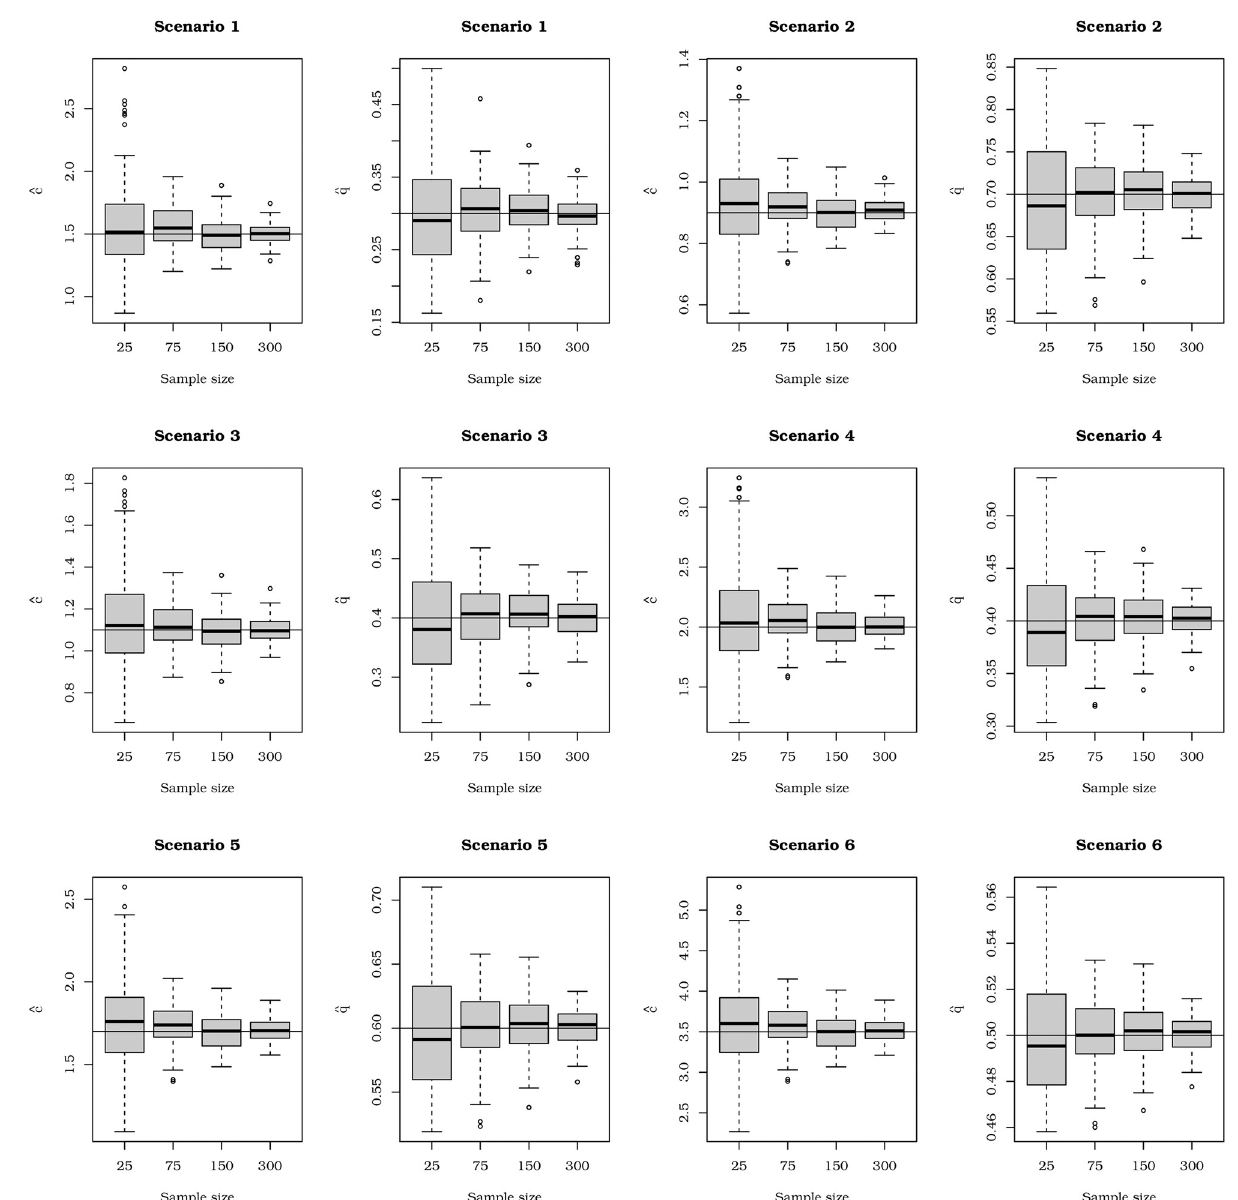
Fig 4. Boxplots of the first hundred estimates of the Monte Carlo simulation for some sample